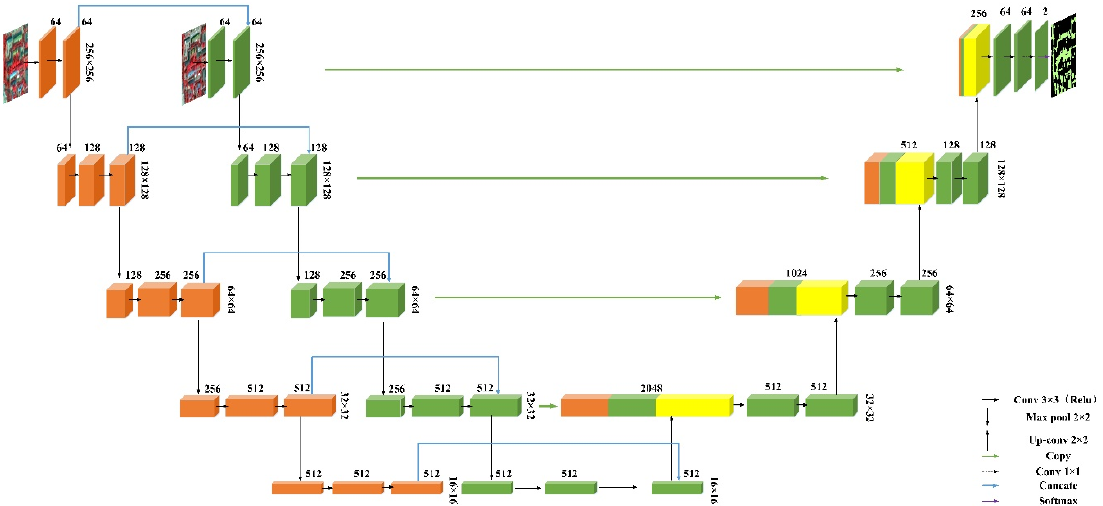
Figure 5. Architecture of DBFU (double-branch U-NET of feature fusion). Each green box represents the multi-channel feature map obtained by the first-phase satellite image operation, each orange box represents the multi-channel feature map obtained by the second-phase satellite image operation, the yellow box represents the feature map after transposed convolution. The number of channels is above the box, and the size is on the right side of the box. Different arrows represent different operations.